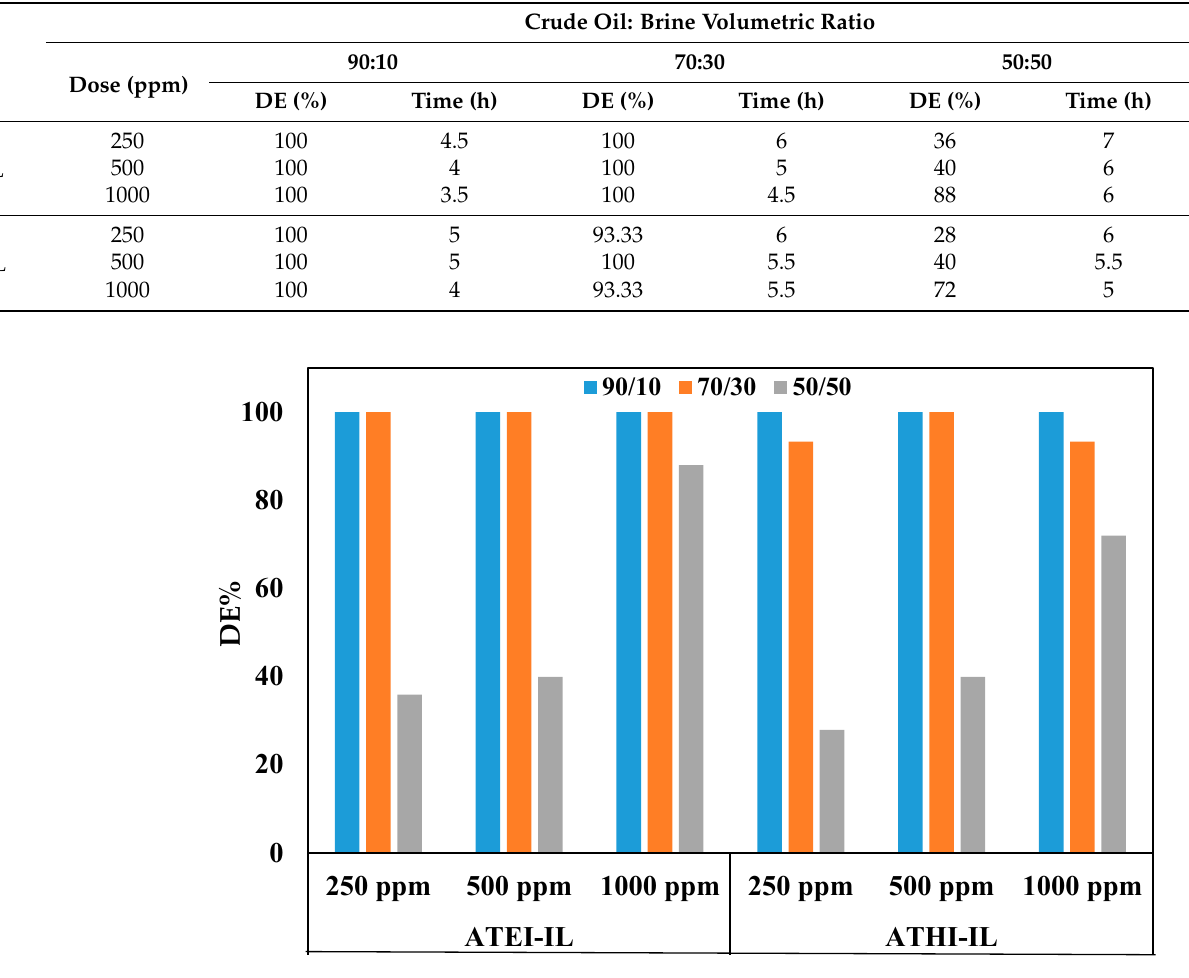
Figure 6. Demulsification efficiency of ATEI-IL and ATHI-IL using different concentrations .